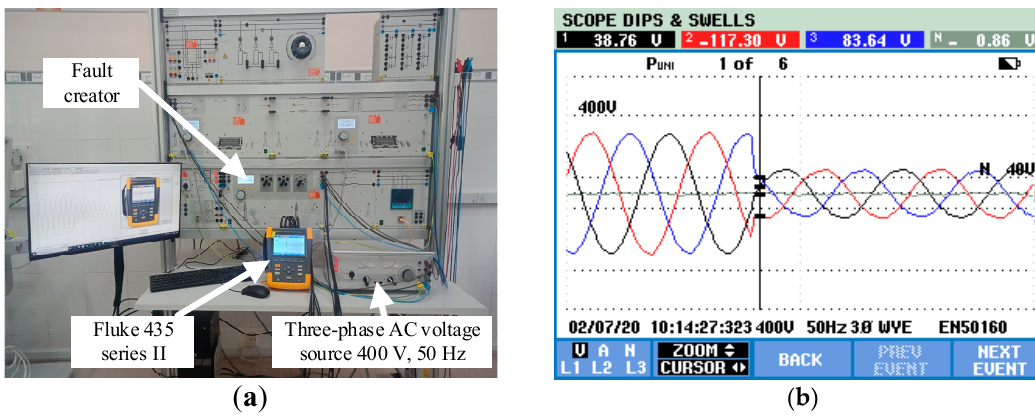
Figure 26. The test system for acquiring PQ disturbance data: ( a ) testbench in the laboratory; ( b ) an actual sag voltage event recorded by Fluke 435 series II on 2 July 2020.